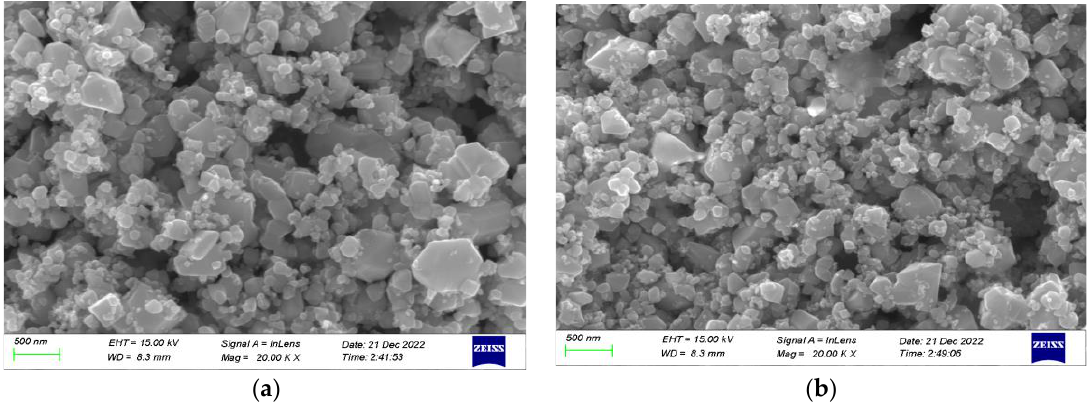
Figure 1. Schematic diagram of the material structure: ( a ) SnO 2 and Al 2 O 3 structure; and ( b ) SnO 2 /Al 2 O 3 composite structure.